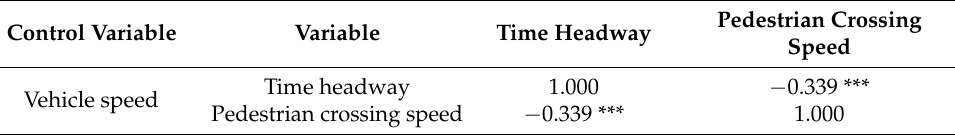
Table 5. Analysis result of the partial correlation between vehicle speed and pedestrian crossing speed. Control Variable Variable Vehicle Speed Table 4. Analysis result of the partial correlation between time headway and pedestrian crossing speed.